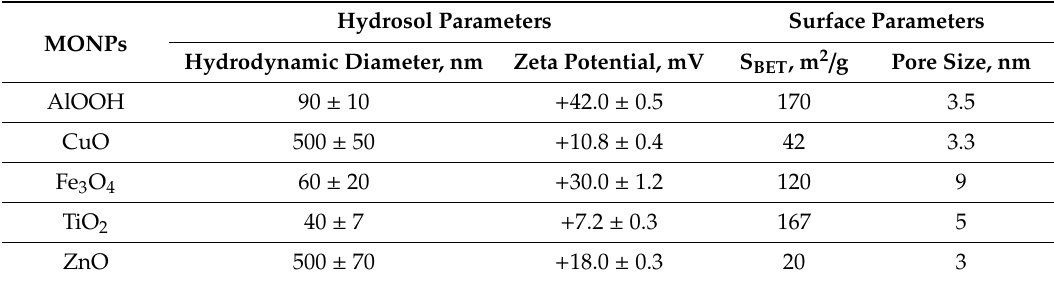
Table 2. Hydrodynamic size, zeta potential, and surface parameters of